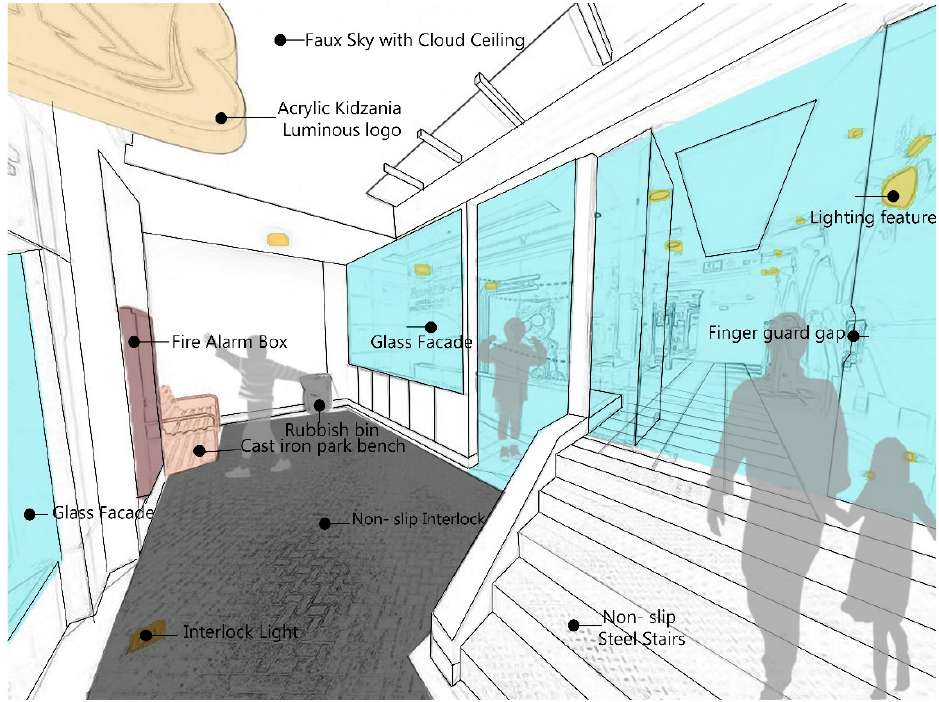
Figure 4. Some architectural details preventing children’s injuries in Kidzania. Source(s): Authors (2022).